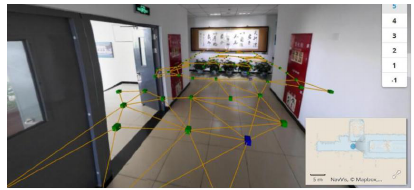
Figure 5. Navigation map after registration